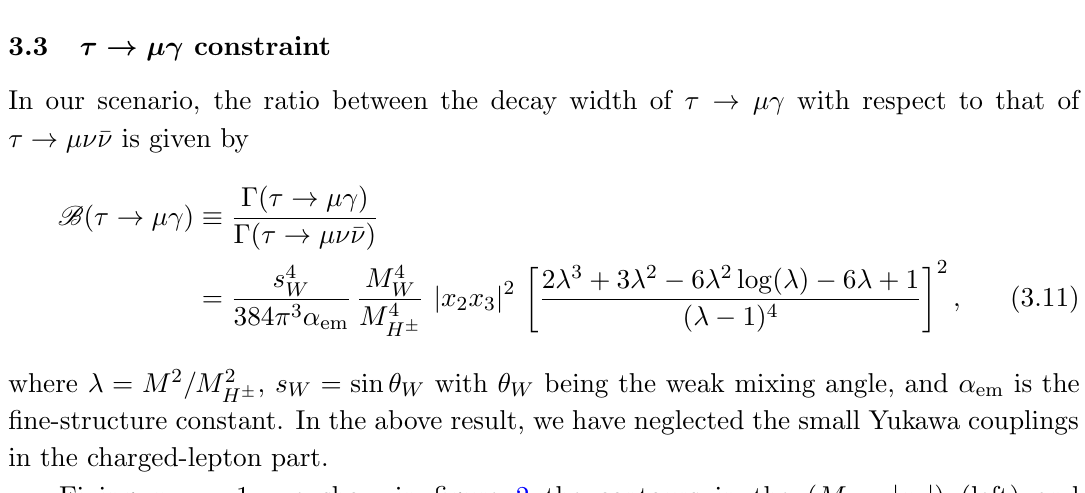
Figure 2 . Constraint from the ratio B ( (cid:28) ! (cid:22)(cid:13) ) de(cid:12)ned by eq. (3.11). Left: ( M with di(cid:11)erent heavy neutrino masses. Right: ( M; j x 3 j ) contours with di(cid:11)erent charged-Higgs boson masses. The regions below the curves are allowed by the current